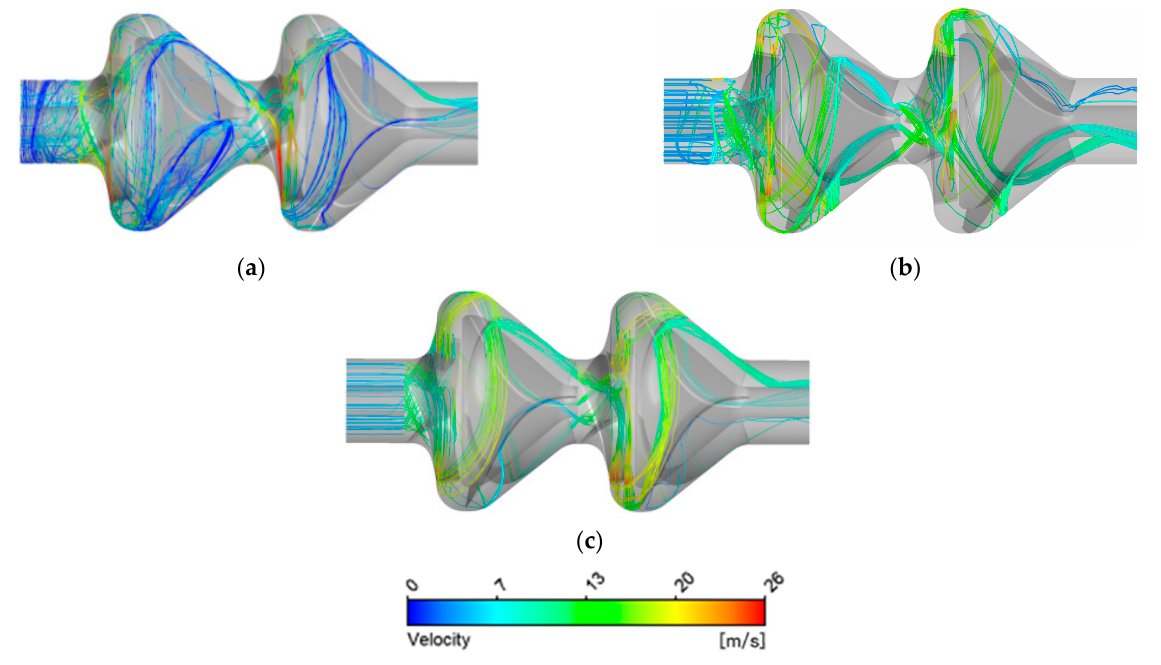
Figure 17. Particle movement trajectories in the calculation domain: ( a ) 0.68 Q d ; ( b ) 1.0 Q d ; ( c ) 1.33 Q d .